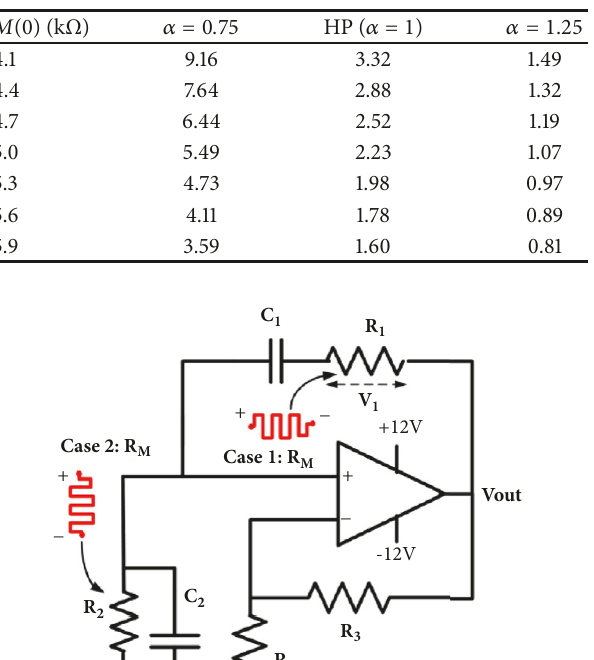
Table 3: Δ𝑓 𝑜𝑠𝑐 (Hz) for various 𝑀(0) ’s.